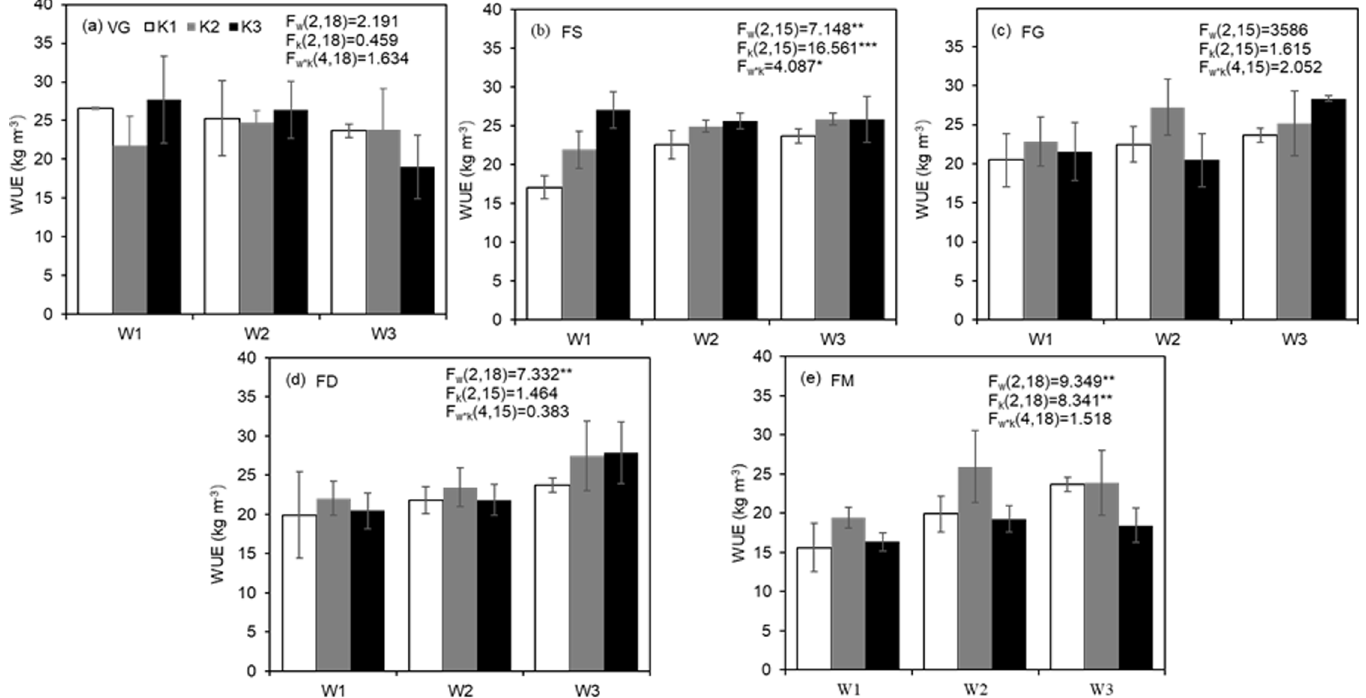
Fig 2. Tomato water use efficiency (WUE) as effected by soil moisture and K supply during vegetative growth (VG, a) stage, flower and fruit setting (FS, b) stage, fruit early growth (FG, c) stage, fruit development (FD, d) stage and fruit maturity (FM, e) stage. W1, W2 and W3 denote three soil moisture levels, i.e., 60–70% θ 70–80% θ f and 80–90% θ f , respectively. K1, K2 and K3 denote three K application rates, i.e., 0 g K 2 O � kg -1 soil, 0.46 g K 2 O � kg -1 soil and 0.92 g K 2 O � kg -1 soil, respectively. are the F values of the variance analysis for soil moisture, K rate and their interaction effect, Error bars indicate standard error of the mean (n = 3 or 2). F w , F k and F w × k respectively. The symbol of � and �� indicate significant effect at 0.05 and 0.01 level, respectively.